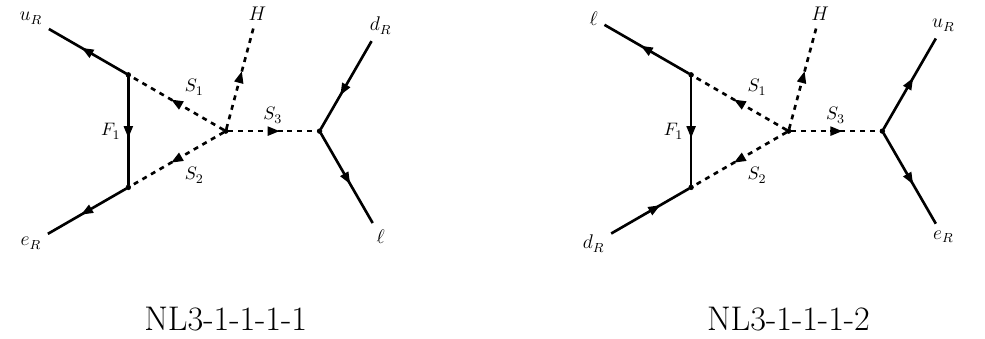
Figure 7 . Attach the fields of the 0 νββ decay operator O † NL-1-1-1 at the vertex A . On the right side, the dashed lines stand for scalar fields while the wavy lines denote vector fields. Note that the chirality of the external fermions fixes the mediator to be either vector or scalar boson.